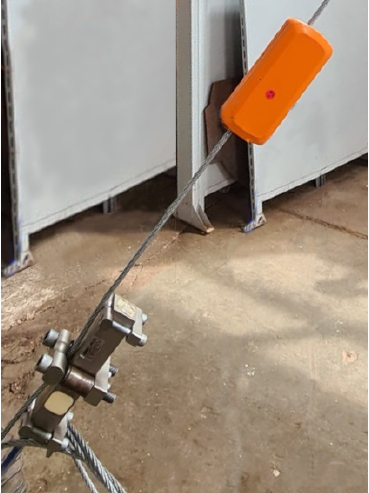
Figure 6. Photo of the leaf node and tension sensor attached to the tower